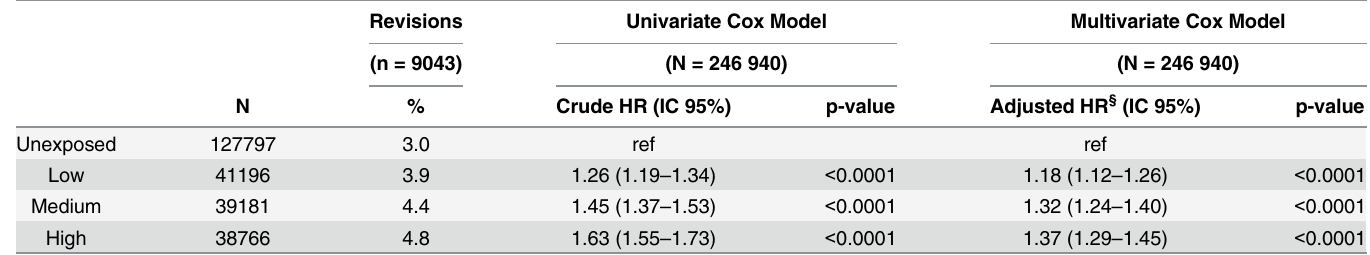
Table 3. Associations between exposure level to BZDs and prosthetic revision.